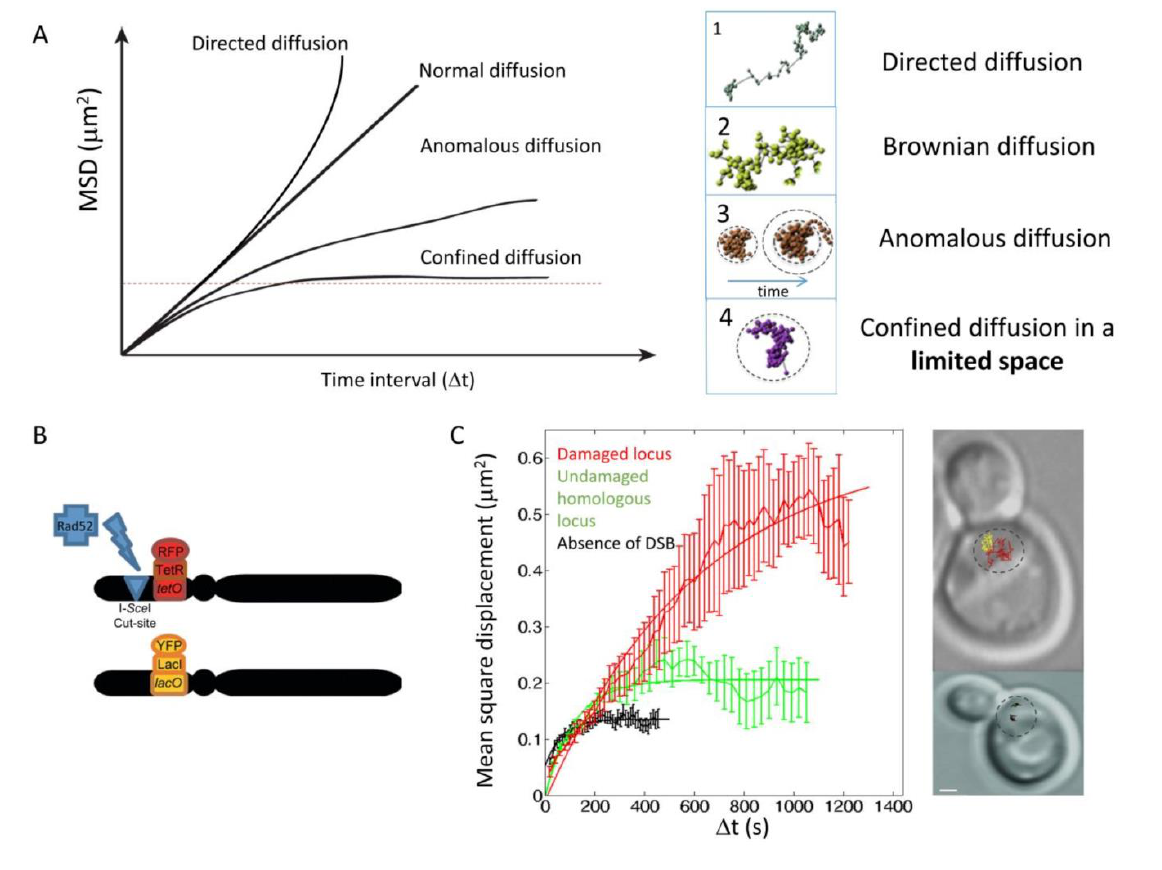
FIGURE 18: Studying chromatin mobility. (A) Left, theoretical Mean Square Displacement (MSD) curves for directive, Brownian, anoma- lous and confined diffusion. Right: corresponding typical trajectories for each mode of diffusion. (B) Experimental design to measure mobility at a chromosomal locus before and after DNA damage. A strain harboring two homologous and tagged loci (a tetO/ TetR-RFP array inserted at the URA3 locus, and a lacO/ LacI-YFP array inserted at the homologous URA3 locus) contains, a single I- Sce I cut-site located 4 kb from the tetO array. A galactose-inducible I- Sce I inserted at the LYS2 locus allows regulated induction of a single DSB under galactose control. (C) Left, experimental MSD curves obtained from the diploid strain described in (B) Black: MSD curve of either tagged locus in the absence of DNA damage. Red: MSD curve of the tetO locus, after an I- Sce I-induced DSB next to the tetO site (local mobility). Green: MSD curve of the homologous locus harboring a lacO array, after an I- Sce I-induced DSB next to the tetO site (global mobility). Right: to illustrate the change in chromatin mobility, typical trajectories are shown (black trace: URA3 locus before DNA damage; red trace: damaged URA3 locus; yellow trace: undamaged URA3 homologue). The MSD curves are reproduced from